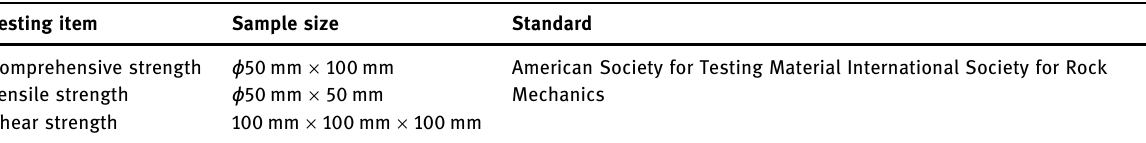
Table 1: Testing type, specimen dimensions, and standard use in testing Testing item